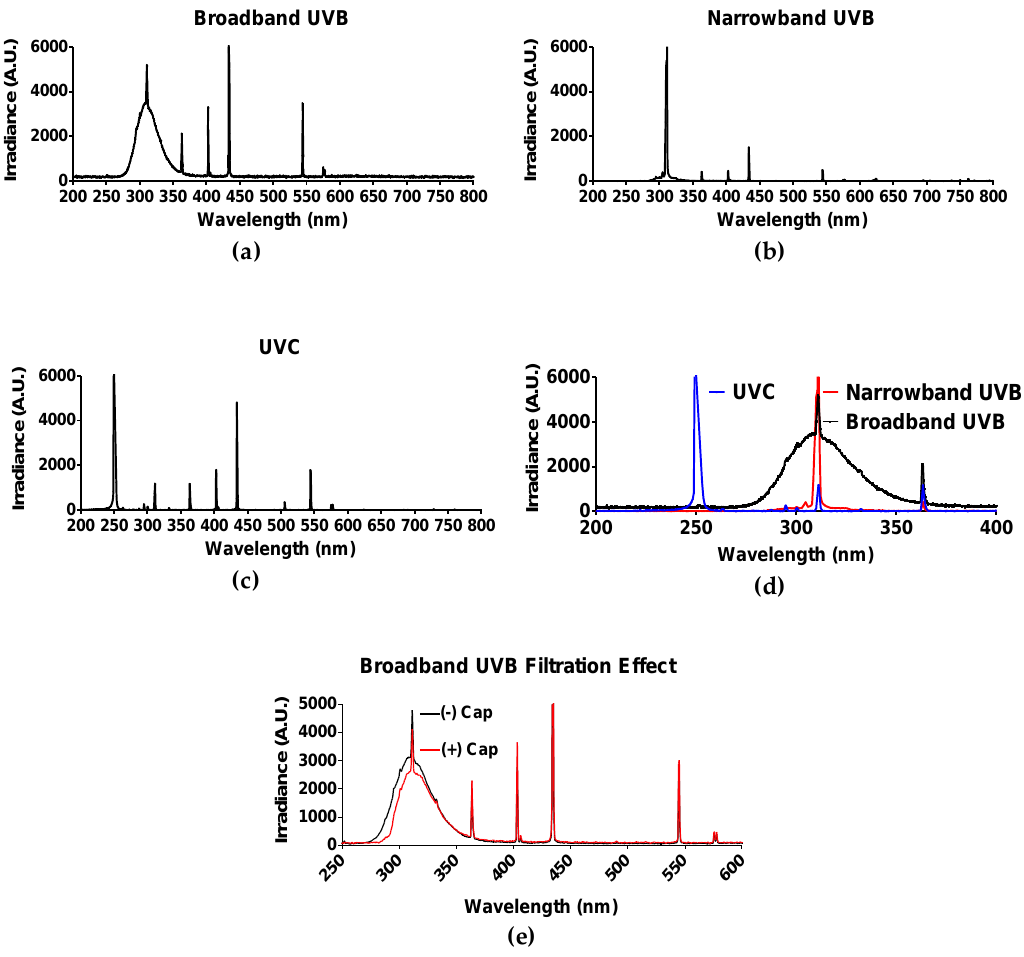
Figure 1. Spectrum of each UV light source. Three light devices were used in this study: ( a ) Broadband UVB-Westinghouse Sunlamp (Broad spectrum 280–350 nm, 63.6 J / m 2 per minute); ( b ) Narrowband UVB-Phillips TL01 (311 nm peak, 82.8 J / m 2 per minute); ( c ) UVC-germicidal lamp (254 nm peak, 58.2 J / m 2 per minute). ( d ) Merge of UV spectrum. Light spectrum was confirmed with spectroradiometer Aseq-LR1. ( e ) Filtration e ff ect of petri dish cap either on ( + ) or o ff ( − ) with conventional broadband ultraviolet-B (BB-UVB) irradiation. The dose rate (J / m 2 ) of each light device was measured with a UVP-UVX radiometer with UVC and UVB probes.